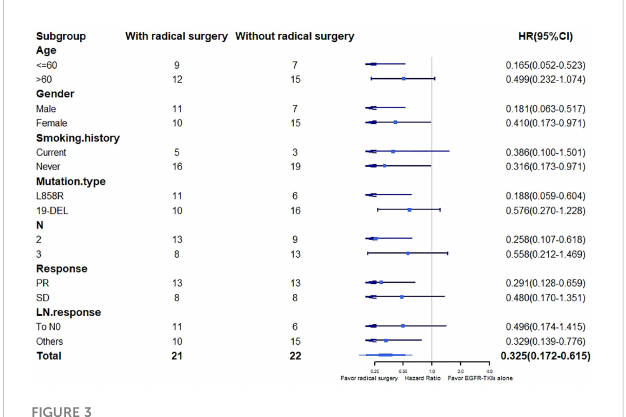
FIGURE 3 PFS in patient ’ s subgroups. PFS, progression-free survival; EGFR -TKI, epidermal growth factor receptor tyrosine kinase inhibitor; PR, partial response; SD, stable disease; LN, lymph nodes; HR, hazard ratio; CI, con fi dence